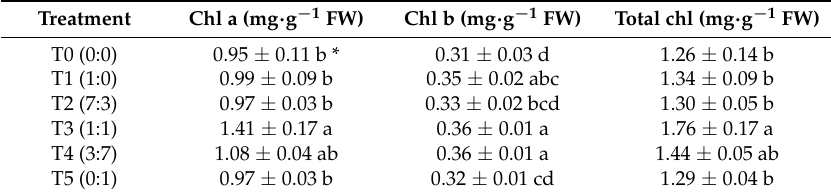
Table 3. Leaf chlorophyll content based on fresh weight of Camellia oleifera ‘XL27’ seedlings fertigated with six nutrient solutions varying in NO 3 − to NH 4+ ratios.